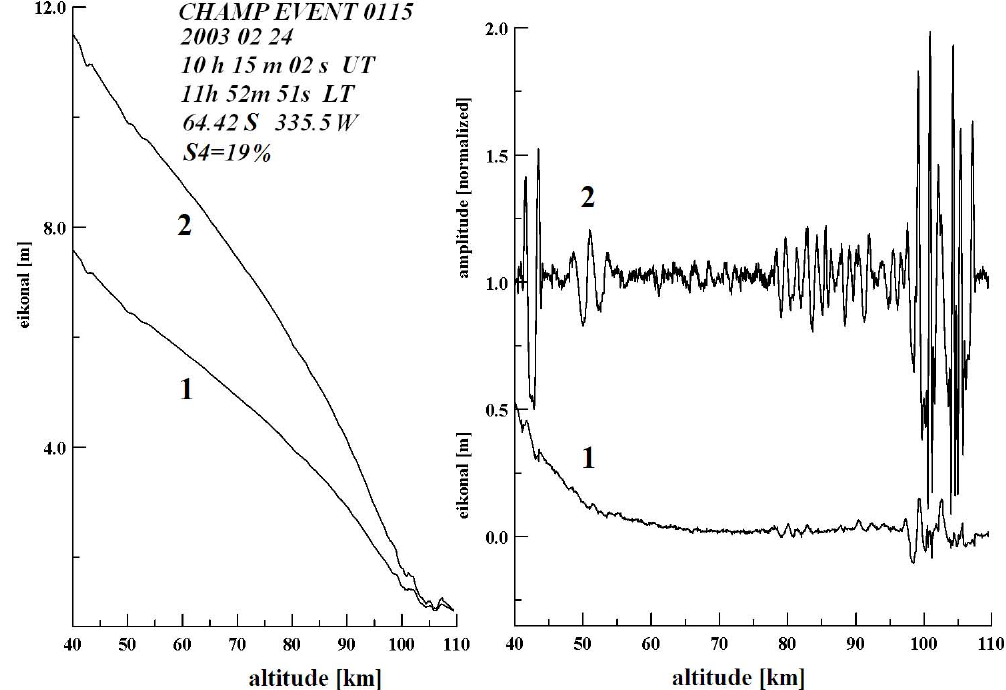
Fig. 4. Amplitude and phase values of the CHAMP RO signals due to the diffraction of electromagnetic waves in the ionosphere (event no. 0115, 24 February 2003). (Left) Eikonal variations at frequencies f 1 and f 2 (curves 1 and 2, respectively). (Right) The combined eikonal 8(t) (curve 1) and amplitude variations at frequency f 1 (curve